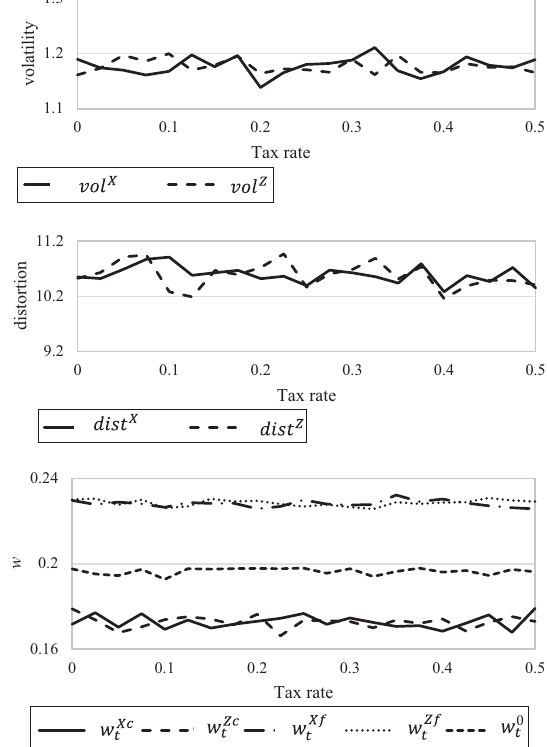
Figure 12. The impact of imposing taxes in markets X and Z on the dynamics of the two